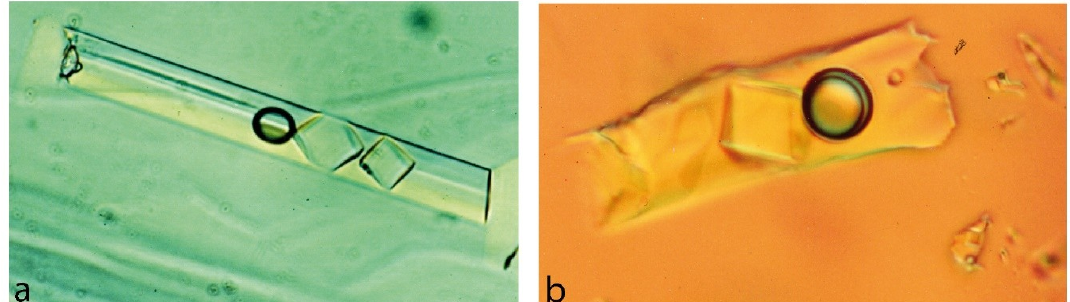
Figure 25. Highly saline basinal fluids trapped by fluid inclusions in Colombian emerald is strong evidence for the evaporitic origin of the mineralizing fluid: ( a ) Emerald from Oriente mine in Chivor (Eastern emerald zone). Primary multi-phase fluid inclusion trapped in an emerald. The cavity, 180 µ m long, contains from the right to the left, two cubes of sodium chloride (halite), a rounded gas bubble, and two minute crystals of calcite all of which are wetted by a salty water occupying 75 vol.% of the cavity; ( b ) emerald from Coscuez (western emerald zone). The cavity, 40 µ m long, contains 75 vol.% of salt water solution, 10 vol.% of gas corresponding to the vapour bubble, 15 vol.% of cubic halite crystal (NaCl), and a rounded crystal of carbonate (on the right of the cavity). The vapour phase is rimmed by liquid carbon dioxide. Photographs: Herv é Conge.